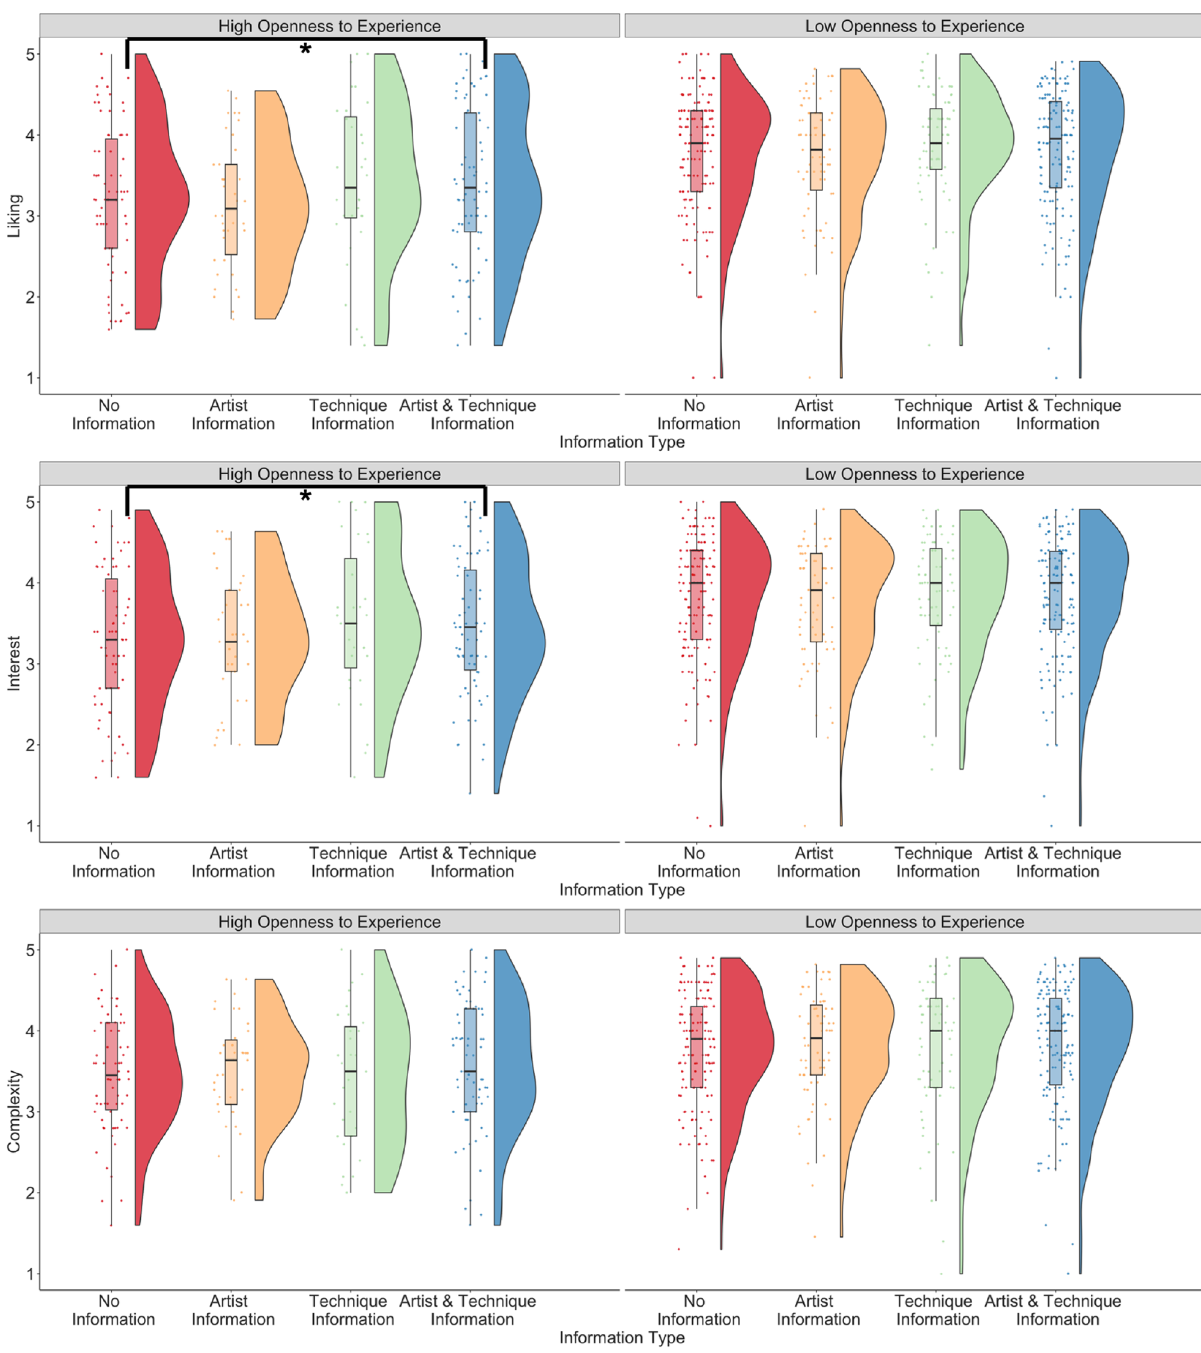
Figure 2. Liking, interest, and complexity ratings when no contextual information was provided to participants, and when information about the artist, information about the technique, and information about the artist and his technique was provided to participants, split by participants who had high and low openness to experience. *p <